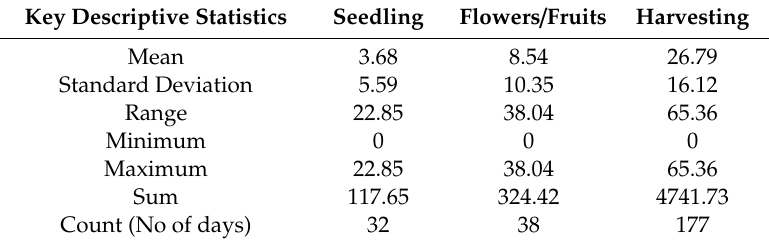
Table A3. Daily cooling power consumption during three stages of the capsicum